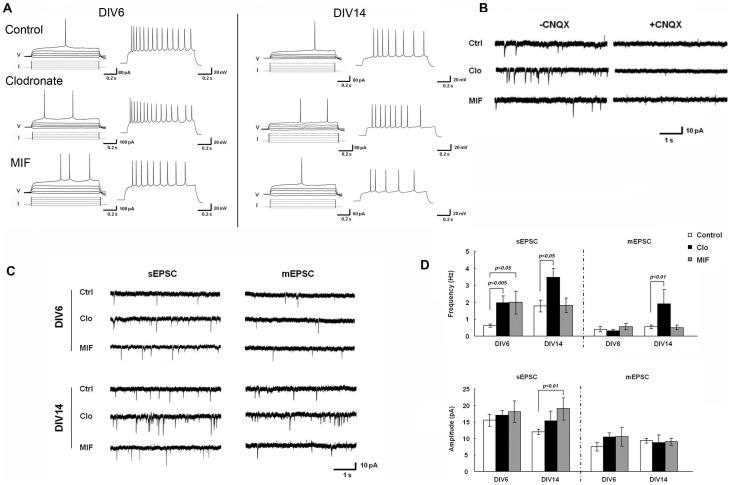
Increased mEPSC frequency in microglia-depleted organotypic hippocampal brain slices.Hippocampal organotypic brain slices obtained from MacGreen mice were treated with clodronate (5 µg/ml) or MIF (100 µg/ml) for 6 or 14 DIV. A. Firing patterns of CA1 pyramidal neurons in response to current injections for control and clodronate- or MIF-treated slices. B. CNQX, an AMPA receptor antagonist, blocks mEPSCs. Representative traces of mEPSC from control or clodronate- or MIF-treated OHBS at DIV14 in the absence or presence of 10 µM CNQX. C. Representative recording traces of mEPSCs from CA1 neurons in control, clodronate- or MIF-treated brain slices. D. Summary of mean mEPSC frequency and amplitude from control, clodronate-, or MIF-treated brain slices. Error bars represent mean ± SEM.